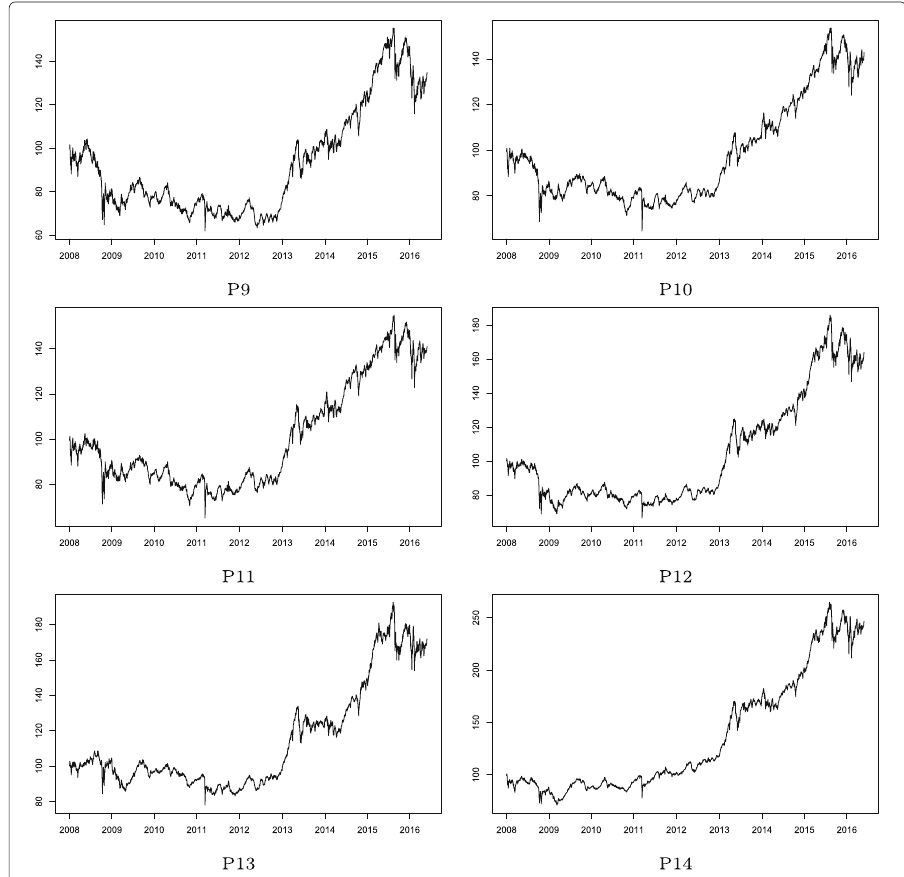
Fig. 3 Stock price indices: Defensive group sub-portfolios. Note: The sub-groups of P9, P10, ..., and P14 correspond to the same group ids shown in Fig. 1. The stock price index of a sub-portfolio is first indexed as 100 at the beginning of the observation period (January 2008); then, the log returns of the mean value of the portfolio is calculated. The price index figures of sub-groups appear to be similar to each other because of the market-wide common price co-movements in the stock market. Some local temporal differences between sub-groups still exist, reflecting local group-specific common